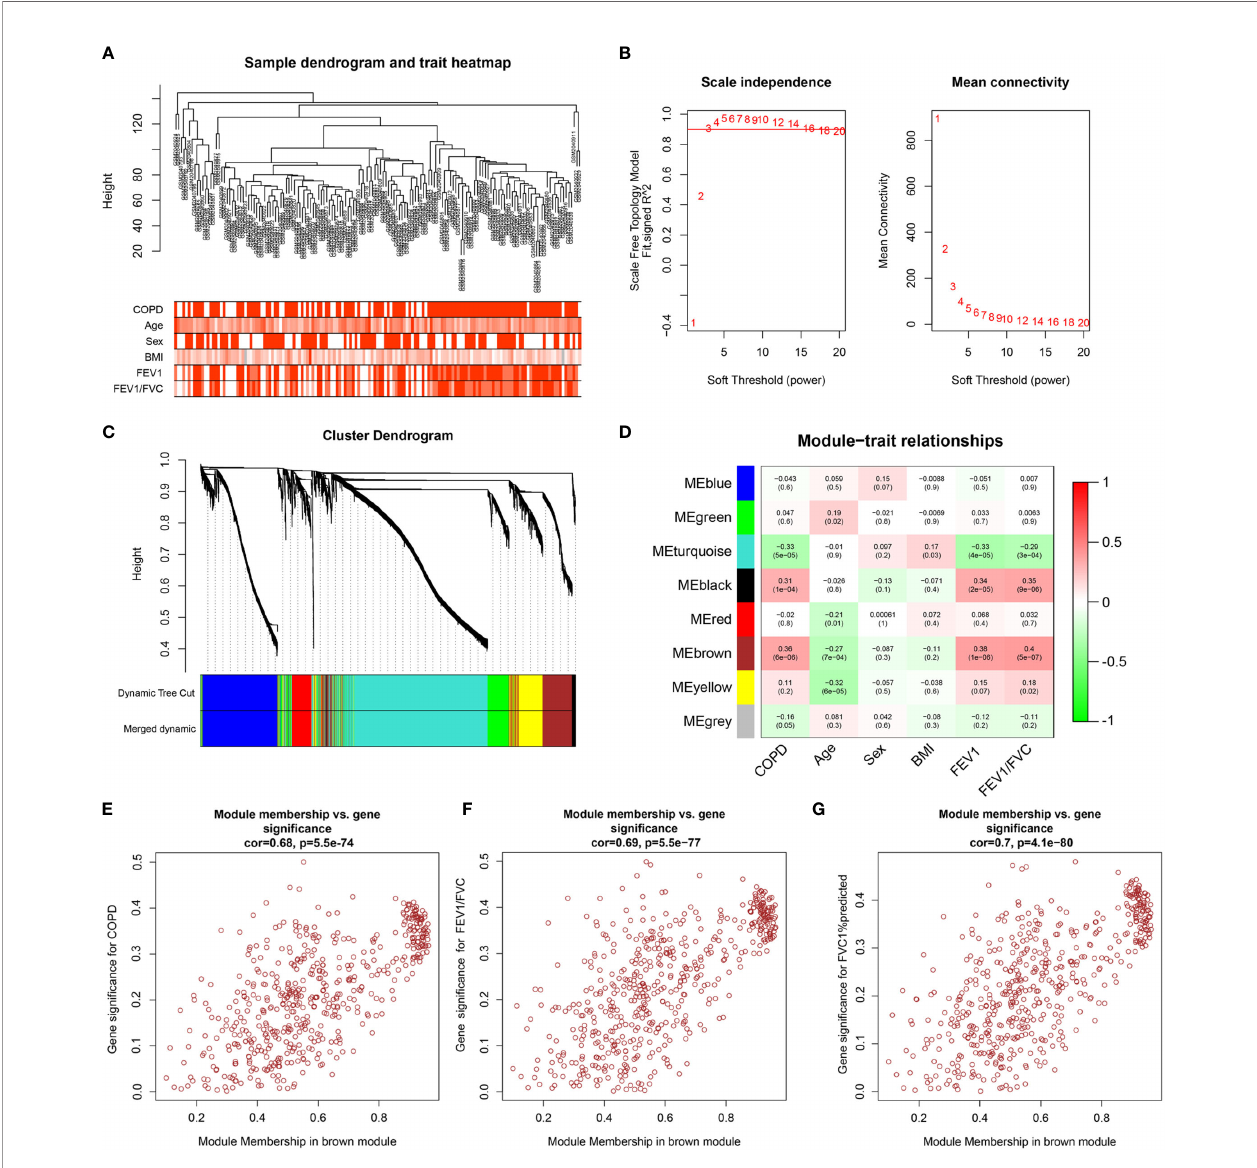
FIGURE 3 | Weighted co-expression network analysis. (A) Sample dendrogram and trait heat map; (B) Analysis of the scale-free fi t index (left) and the mean connectivity (right) for various soft-thresholding powers; (C) Clustering dendrograms of genes based on a dissimilarity measure (1-TOM); (D) Module-trait associations were evaluated by correlations between module eigengenes and sample traits. (E – G) Scatterplot of Gene Signi fi cance for COPD, FEV1/FVC, FEV1% predicted vs. Module Membership in brown